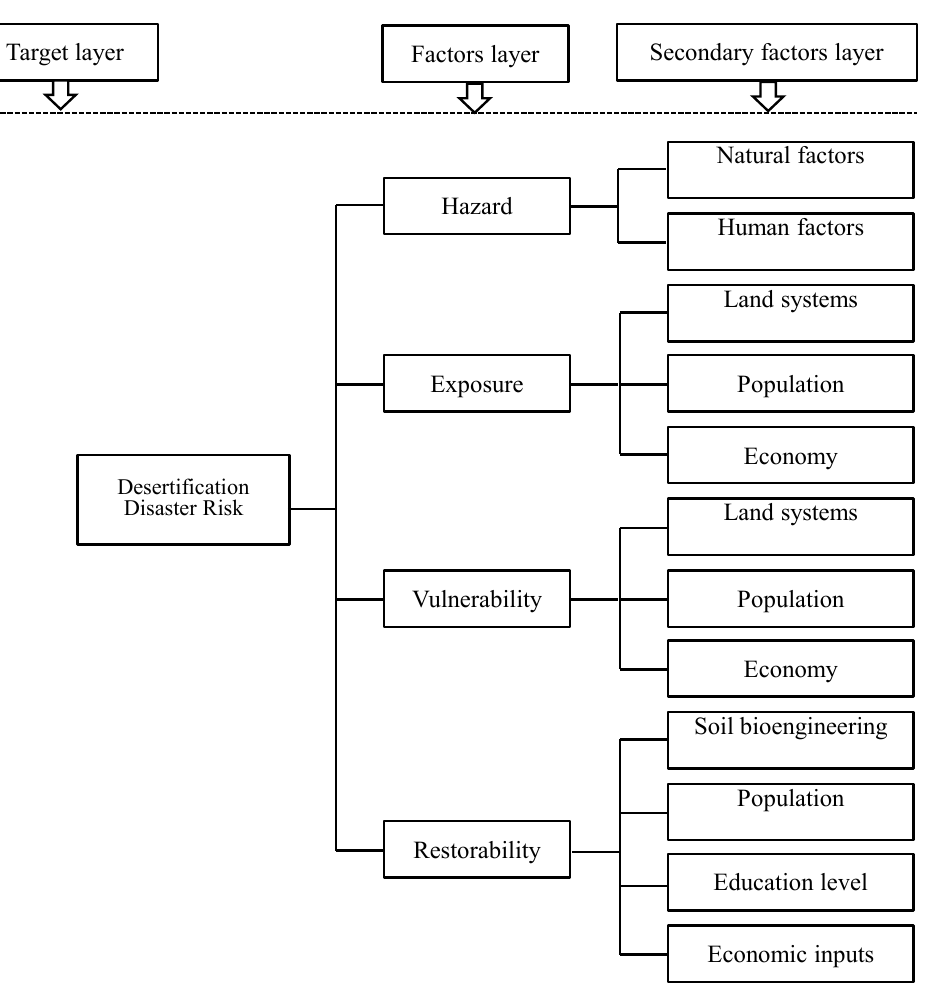
Figure 4. Concept framework of desertification disaster risk.